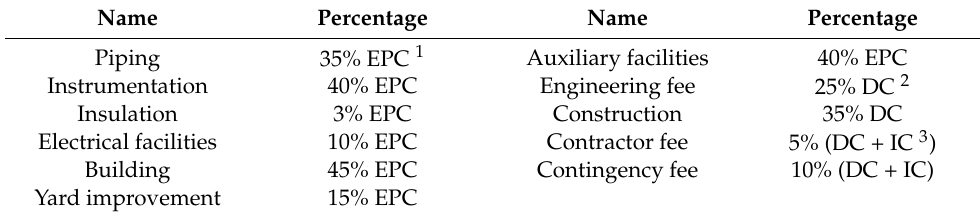
Table A7. The percentage coefficient of direct plant cost factors.